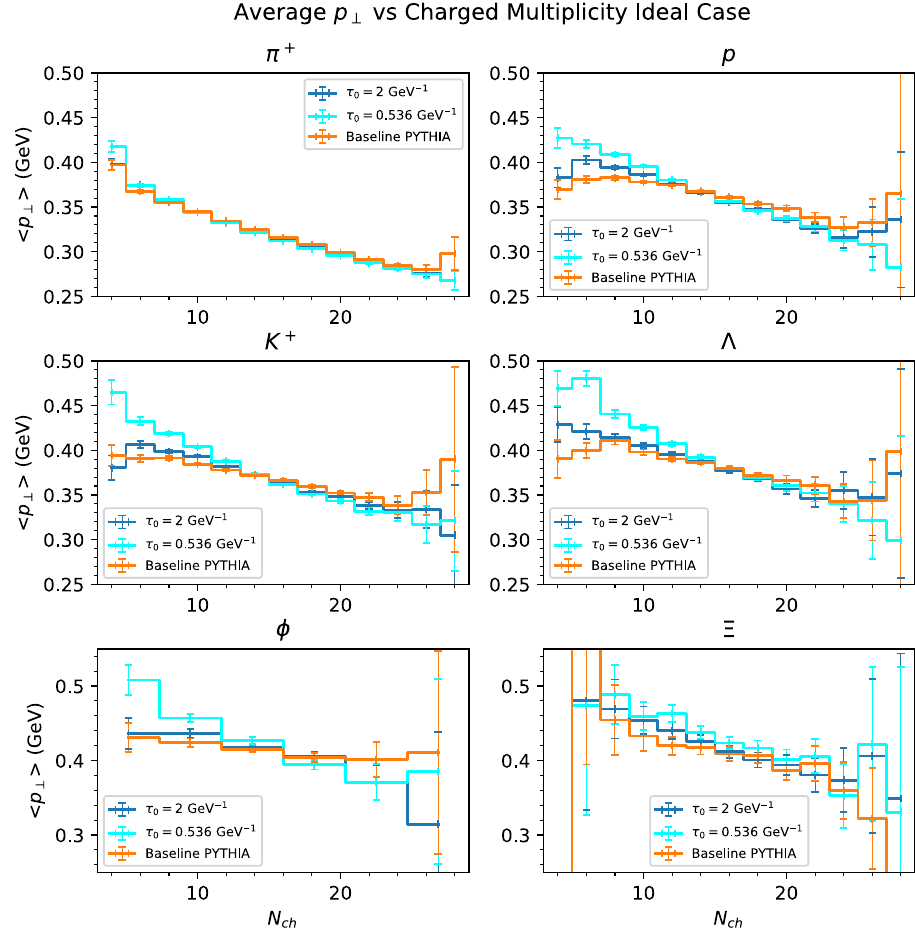
Fig. 7 Mean p ⊥ versus charged multiplicity for π + , p , K + , (cid:14) , φ and (cid:16)